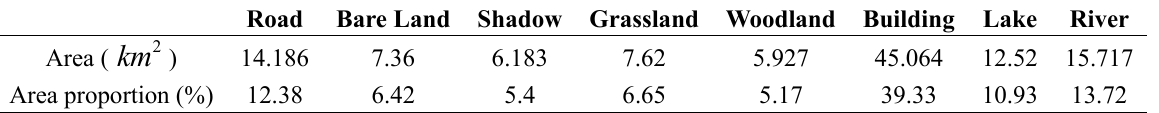
Table 3. The statistics of eight land use/cover